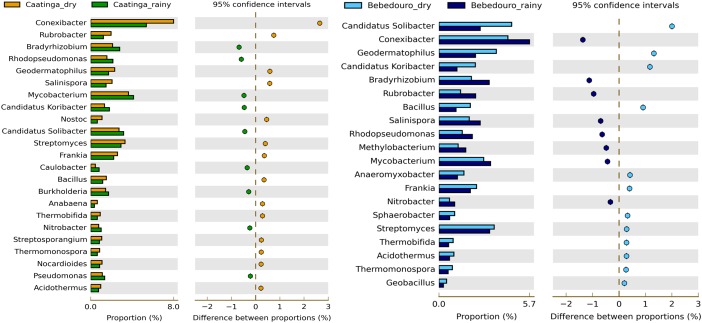
Significant differences in microbial communities at the genus taxonomic levels between dry and rainy seasons of CEF and BEF. Significance was determined by Fisher’s exact test with Story’s FDR correction for multiple comparisons, with corrected p < 0.05 significance filter. Only taxa with difference between proportions > 0.2 (i.e., considered large effect) are shown.